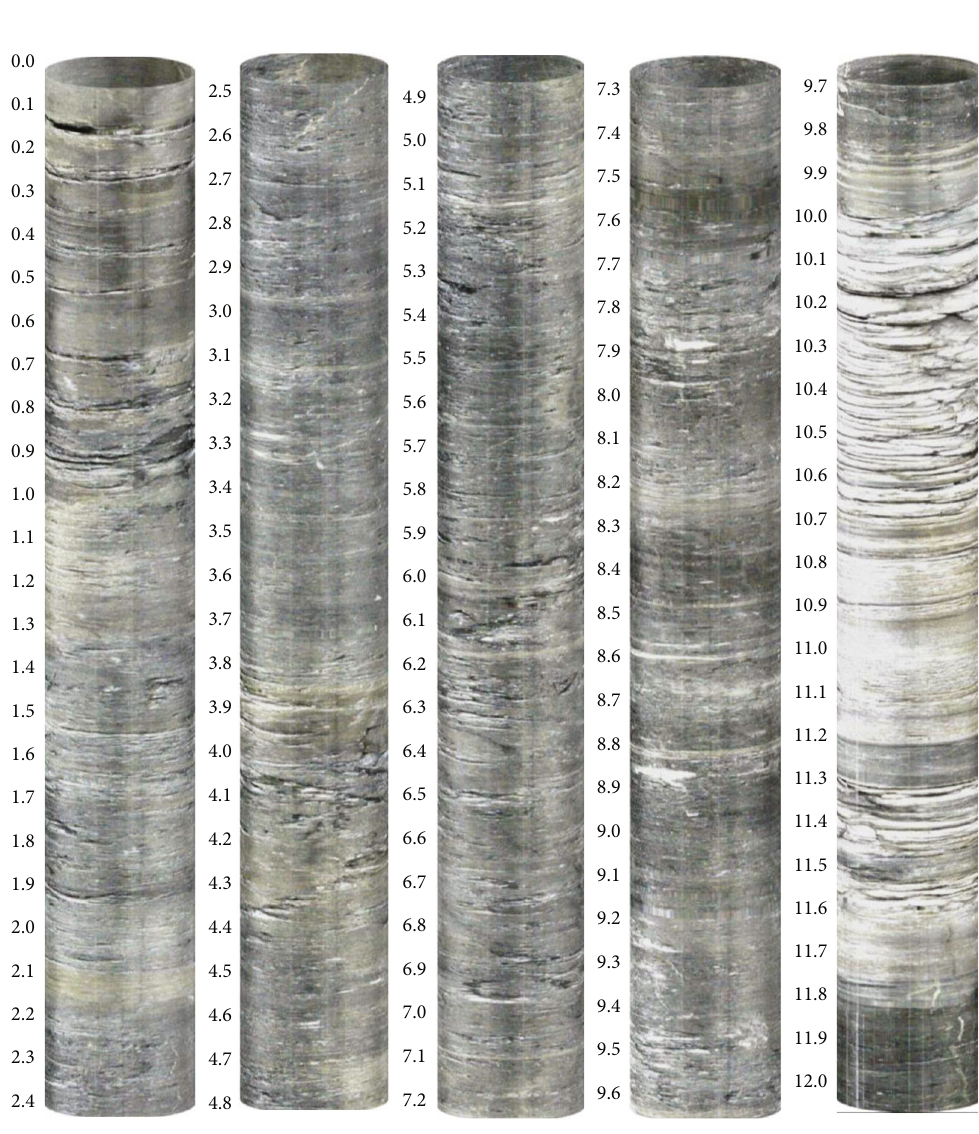
Figure 2: Observation results of roof strata structure.